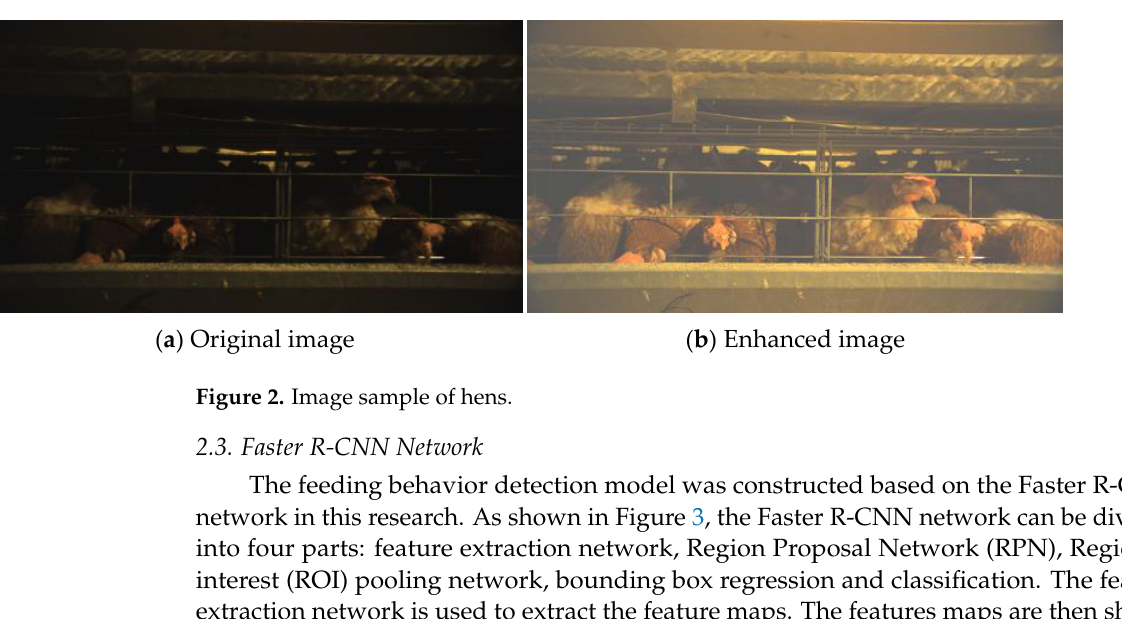
Figure 2. Image sample of hens.